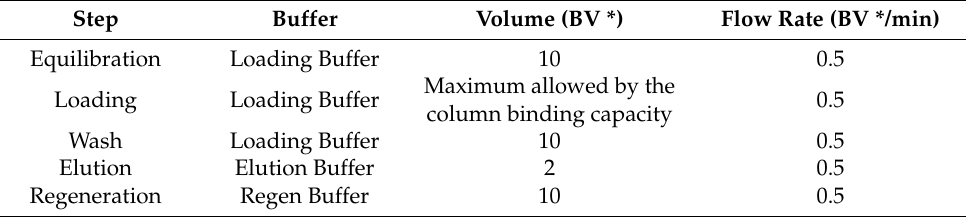
Table 6. Anion exchange chromatography buffers, volumes and flow rates.